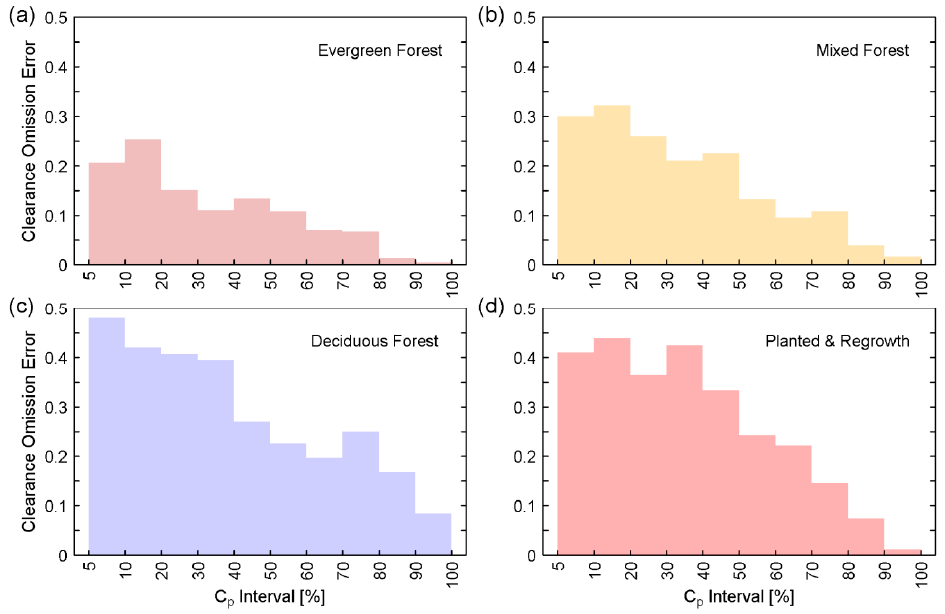
Figure 8. Sensitivity of the Land Surface Water Index (LSWI) change model to sub-pixel clearance by forest type: evergreen forest ( a ); mixed forest ( b ); dry-deciduous forest ( c ); and planted forest and regrowth ( d ) Histograms of forest clearance omission error using pixel cleared proportion (C p ) intervals of 10% were made using the validation samples. Results represent sub-pixel omission errors using a probability threshold where forest clearance commission and omission error are balanced.